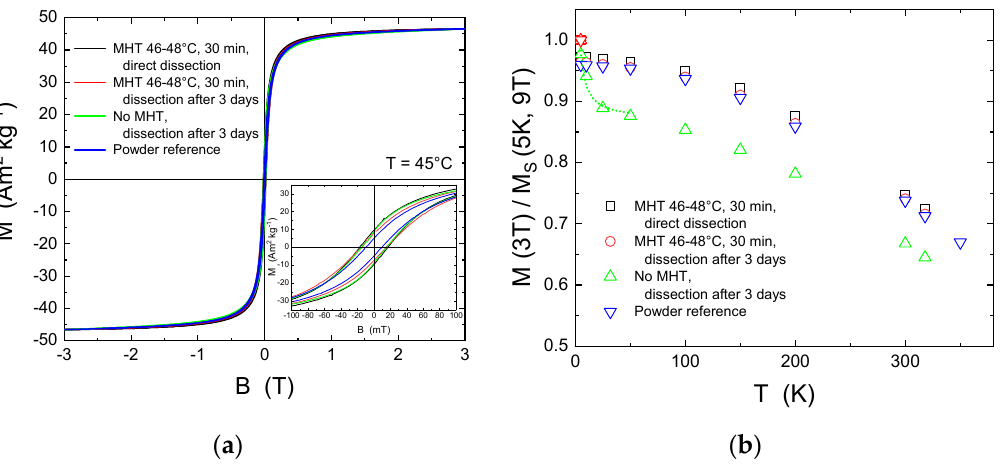
Figure 3 Magnetic properties of MNPs after i.t. injection. ( a ) Magnetic hysteresis of CoFe 2 O 4 MNPs in tumor tissue after MHT (direct dissection and after 3 days), without MHT, and the powder reference; ( b ) normalized magnetization of the four samples as function of temperature.